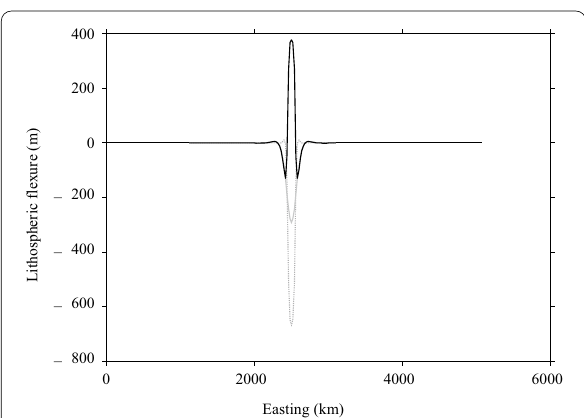
Fig. 6 Cross sections of the lithospheric flexure of uniform T e plates to a cuboid loading. The centre of the cuboid is placed at (2500, 2500) km, with height of 1 km, both length and width of 80 km, density of ρ c . The grey solid line is for a T e = 25 km plate, the grey dotted line is for a T e 5 km plate and the black solid line is calculated by the grey = solid curve minus the grey dotted